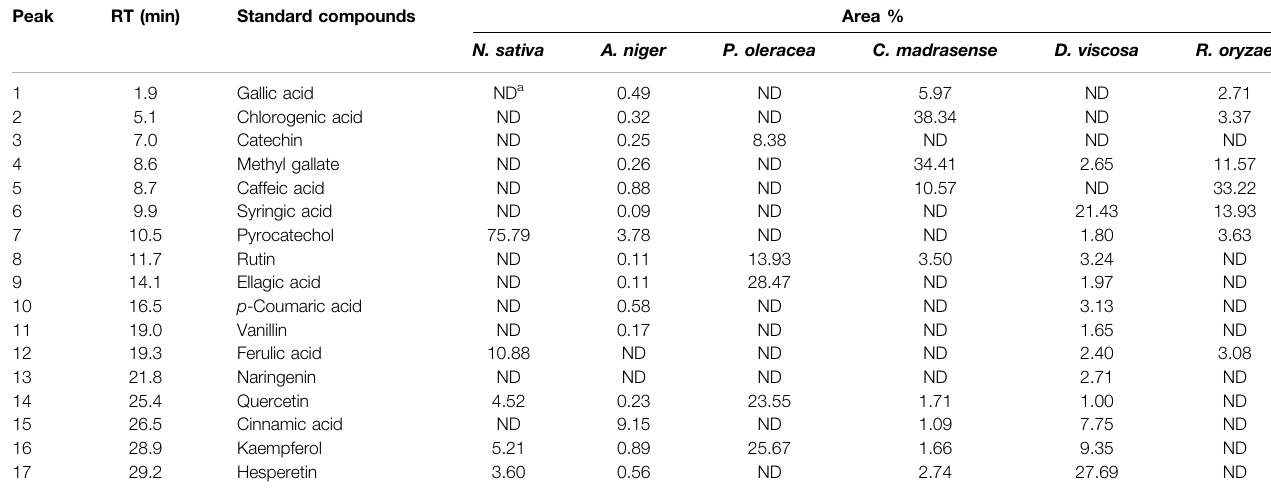
TABLE 4 | Retention time ( R t ), and area percentage of detected phenolic and fl avonoid compounds derived from selected black seeds and their associated fungi. Peak RT (min) Standard